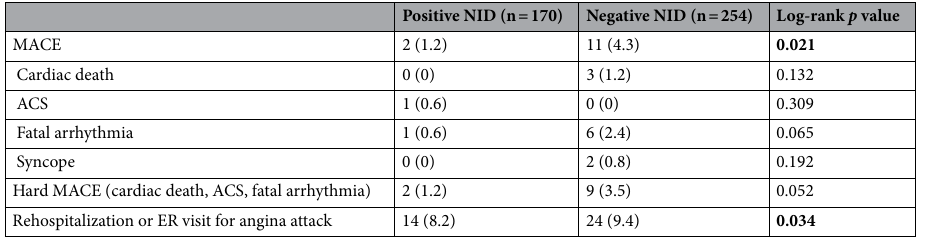
Table 5. Comparison of MACE in positive NID and negative NID groups. Data are expressed as numbers (percentages). Abbreviations: MACE major adverse cardiovascular event, NID nitroglycerin induced dilation, ACS acute coronary syndrome, ER emergency room. Significant values are in [bold].